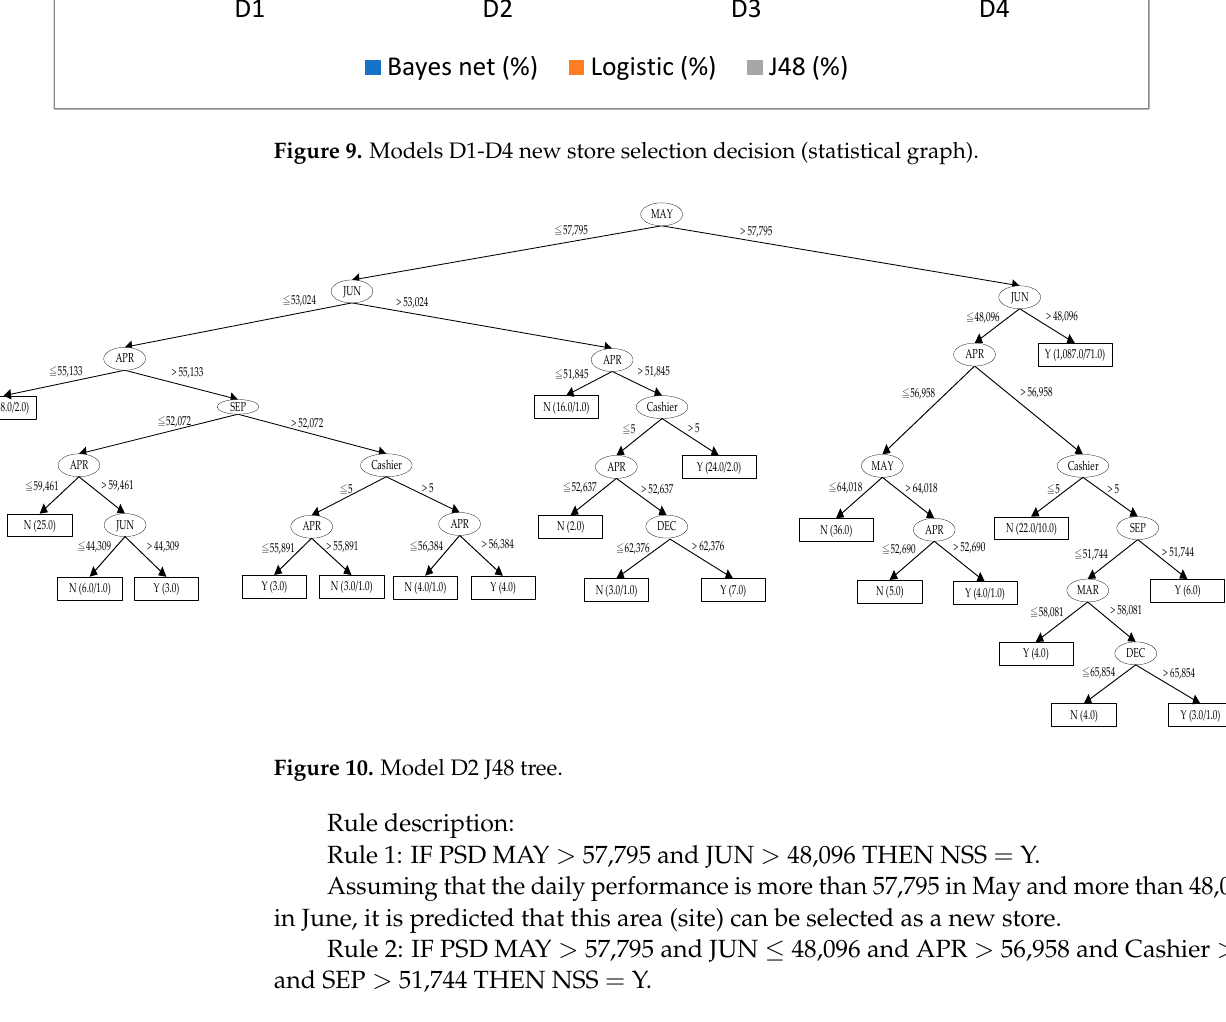
Figure 9. Models D1-D4 new store selection decision (statistical graph). Results of Experiment 4: